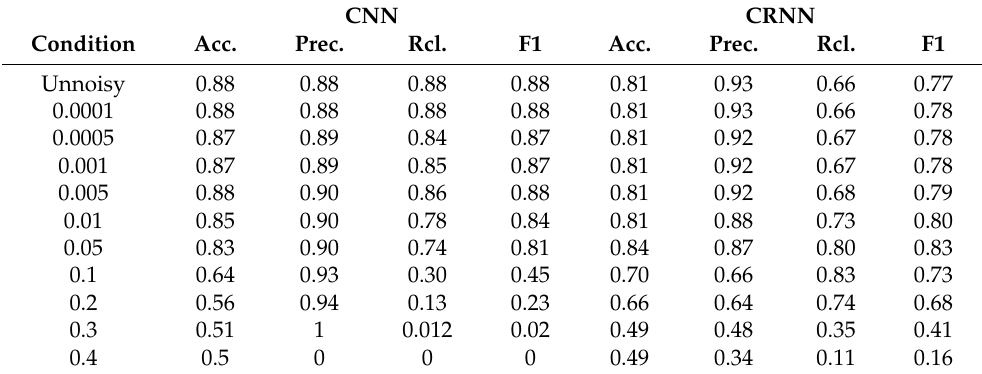
Table 1. CNN / CRNN classification performance on noise-free test datasets followed by increasing levels of white noise. CNN CRNN Condition Acc.